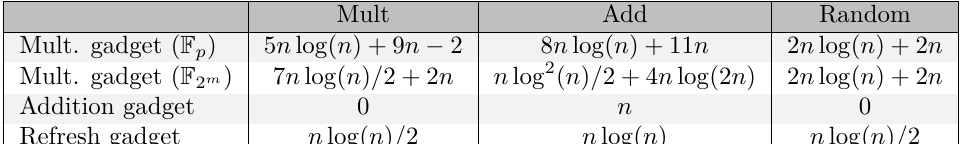
Table 2: Operation counts for GJR + .